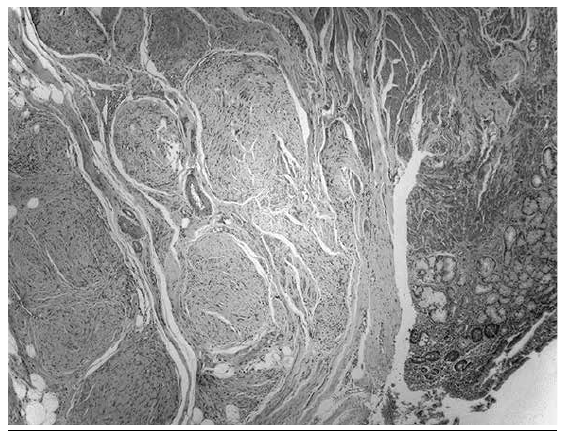
FIguRe 1 – Plexiform neurofibroma: tortuous expansion of multiple nerve fascicles caused by neurofibroma cells, affecting gastric wall, HE, 40× HE: hematoxylin and eosin stain.